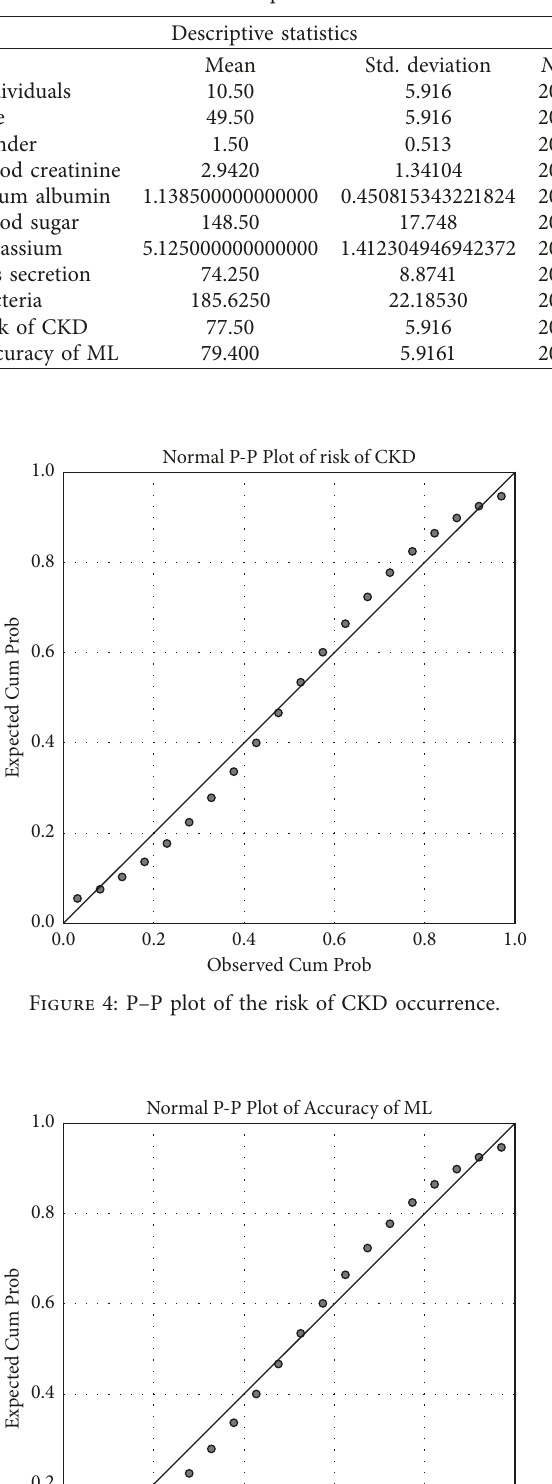
Table 3: Descriptive statistics.